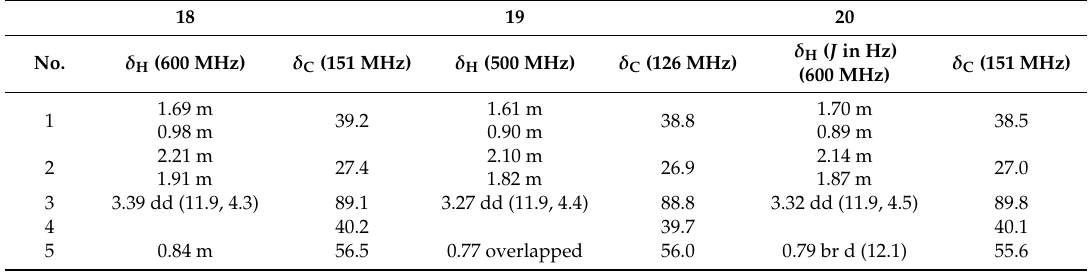
Table 7. 1 H and 13 C-NMR data of 18 – 20 in Pyridine- d 5 ( δ in ppm, J in